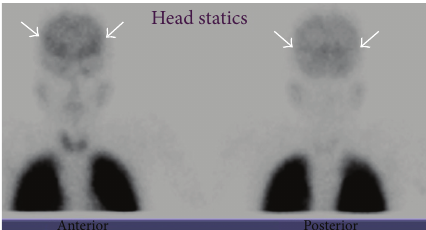
Figure 2: Anterior and posterior static head images of lung per- fusion scan images with Tc-99m macroaggregated albumin (MAA) show focal tracer uptake noted at the region of brain (white arrows) and stomach and faint renal uptake (not shown) indicative of right- to-left